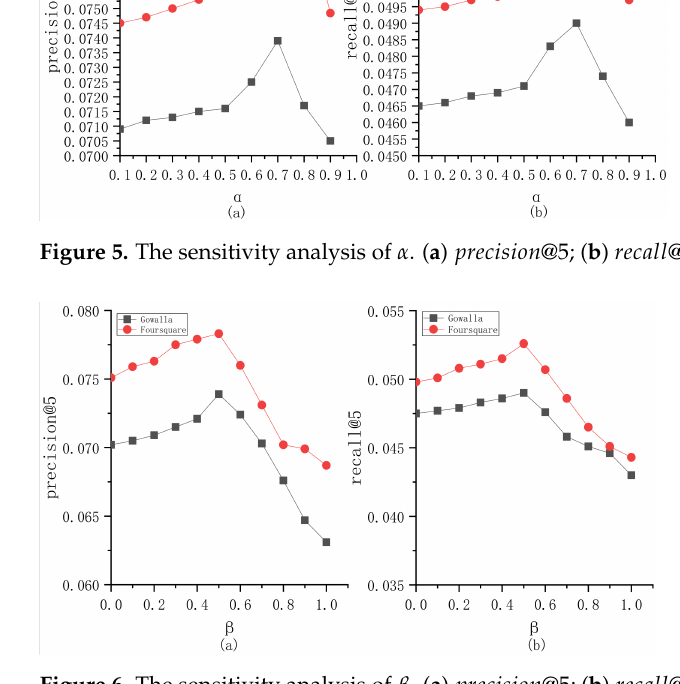
Figure 6. The sensitivity analysis of β . ( a ) precision @5; ( b ) recall